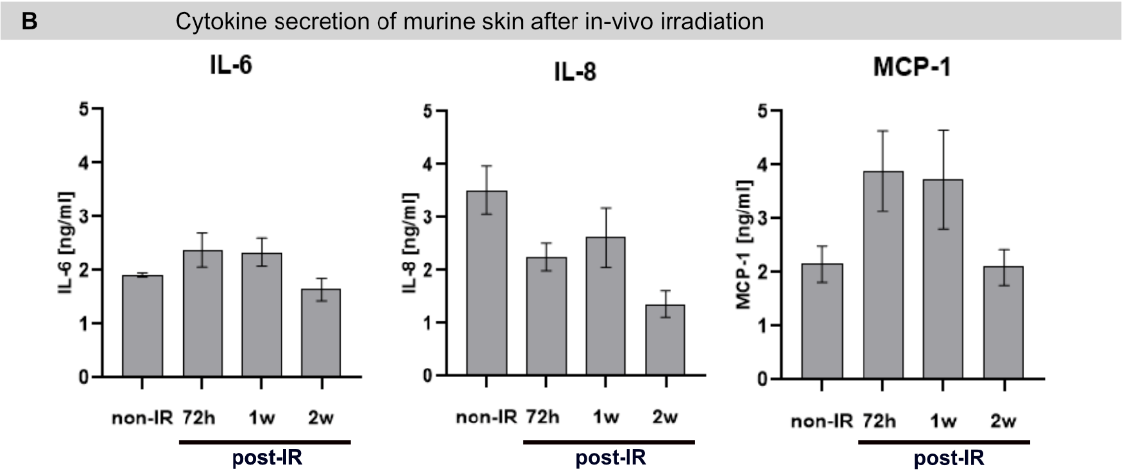
Figure 4. H2A.J and SA-ß-Gal expression in murine skin before and after fractionated in vivo IR exposure. ( A ) Graphic presentation of the quantification of H2A.J+ and SA-ß-Gal+ cells in different regions of murine hair follicles (infundibulum, bulge, papilla) before (non-IR) and at different time-points after fractionated in vivo irradiation (72 h, 1 w, and 2 w post-IR). * p < 0.1; ** p < 0.01; *** p < 0.001 ( B ) Graphic presentation of the quantification of IL-6, IL-8, and MCP-1 measured by ELISA in the supernatant of murine skin before (non-IR) and after fractionated in vivo irradiation (5 × 2Gy; 72 h, 1 w, and 2 w post-IR). Data are presented as mean ± SD ( n = 3).